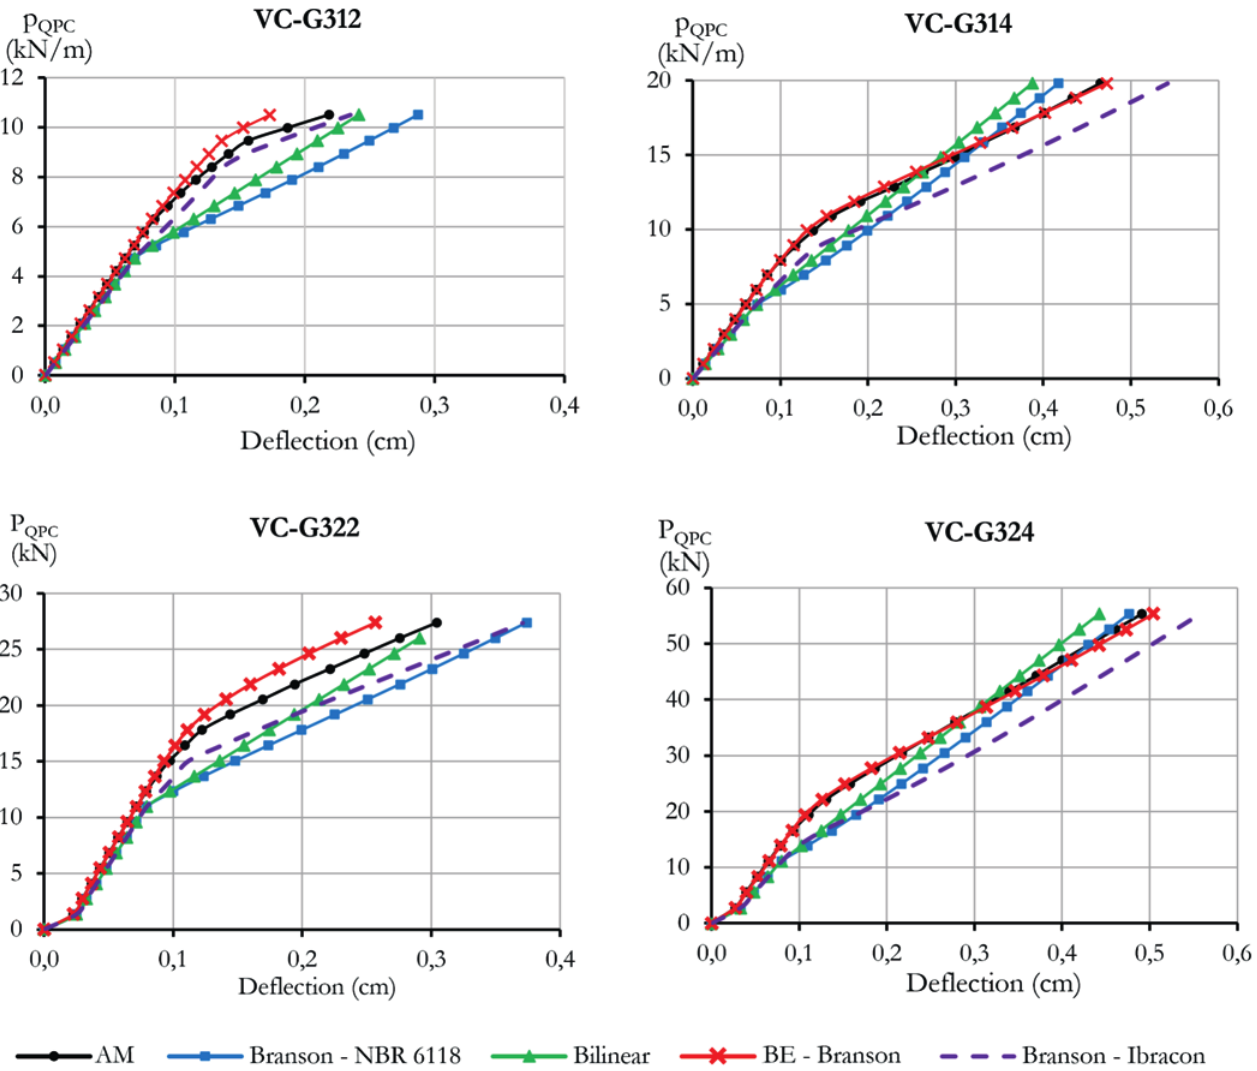
Figure 7 Applied load versus maximum deflection for beams VC-G312, VC-G314, VC-G322 and VC-G324 from the VC-G3